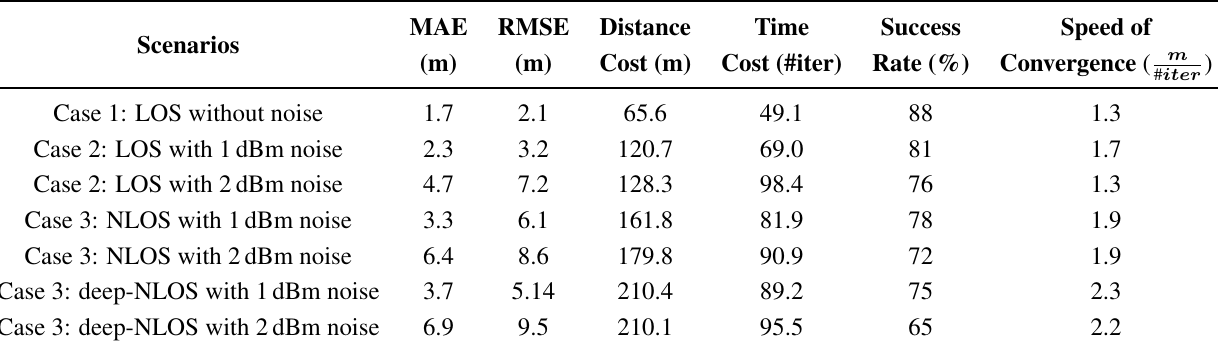
Table 1. Simulation results for all considered